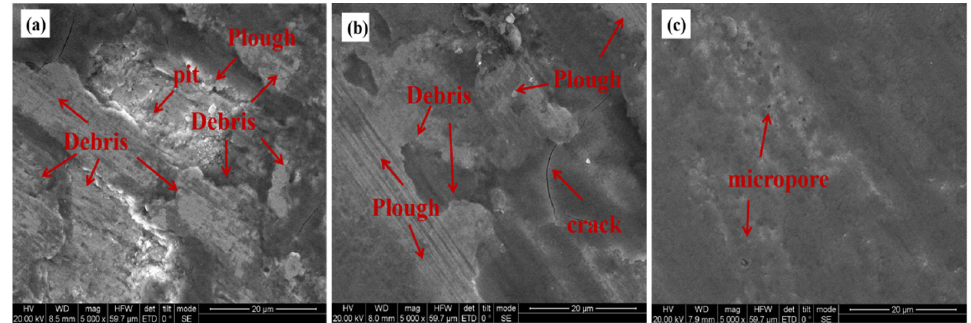
Figure 14. SEM morphologies of the wear marks of samples treated by different processes—( a ) UT; ( b ) LQ; ( c ) LQ-LSP3 .